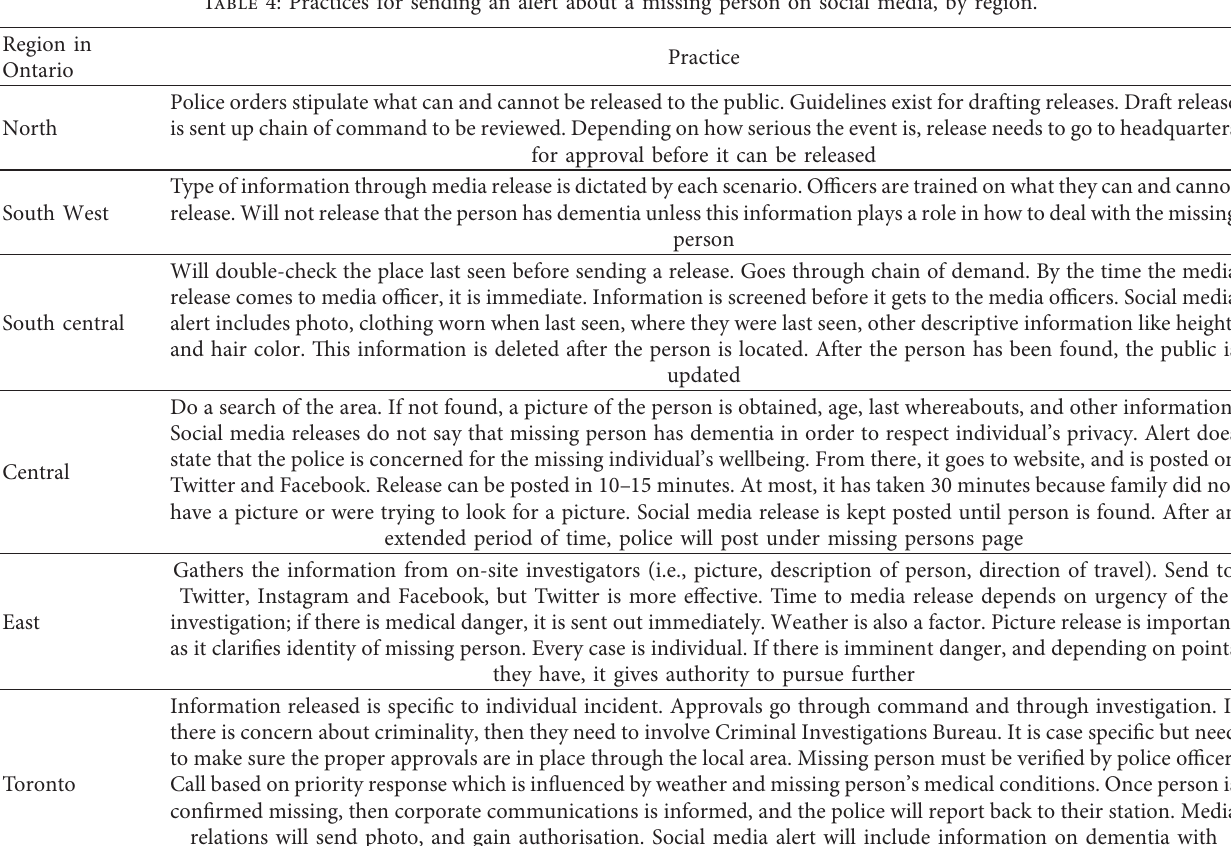
Table 4: Practices for sending an alert about a missing person on social media, by